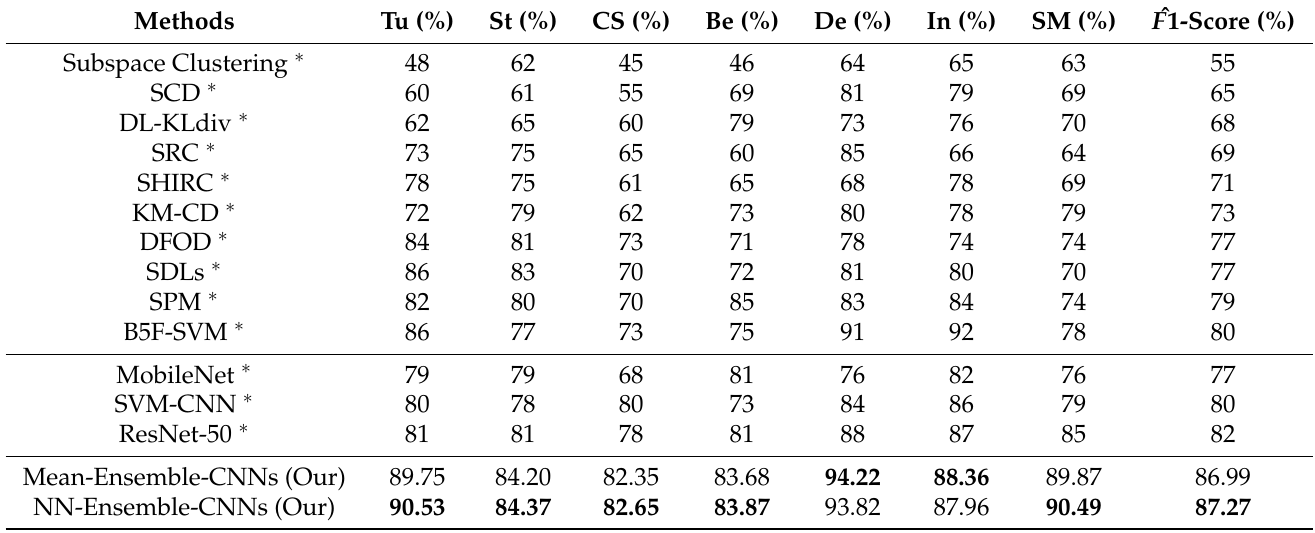
Table 8. Comparison between our approaches and the state-of-the-art methods on CRC-TP database. Where: Tu: Tumor, St: Stroma, CS: Complex Stroma, Be: Benign, De: Debris, In: Inflammatory and SM: Smooth Muscle. ∗ are the comparison methods from [8].